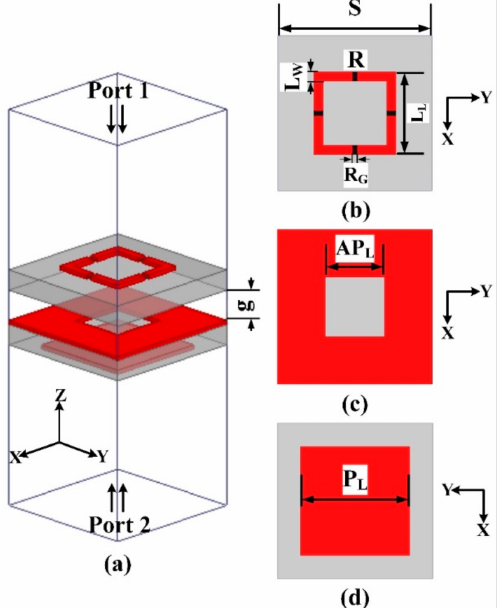
Figure 1. Unit cell structure. ( a ) Perspective view. ( b ) Top side. ( c ) Middle layer. ( d ) Bottom side. (g = 3.2 mm, S = 15 mm, L W = 0.9 mm, L L = 8 mm, R G = 0.5 mm, R = 100 Ω , AP L = variable, P L = 10.5